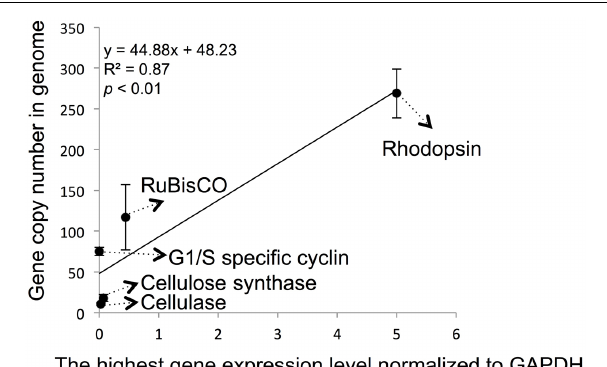
FIGURE 4 | Correlation between specific gene maximal expression level and genomic gene copy number in P. donghaiense . Five genes, including RuBisCo, rhodopsin, cellulose synthase, cellulase and G1/S cyclin, were used in the correlation analysis. Relative expression level and gene copy number were estimated by qPCR. The highest expression level of each gene in diel samples was selected to do analysis. Error bars indicate ± standard deviation of gene copy number in